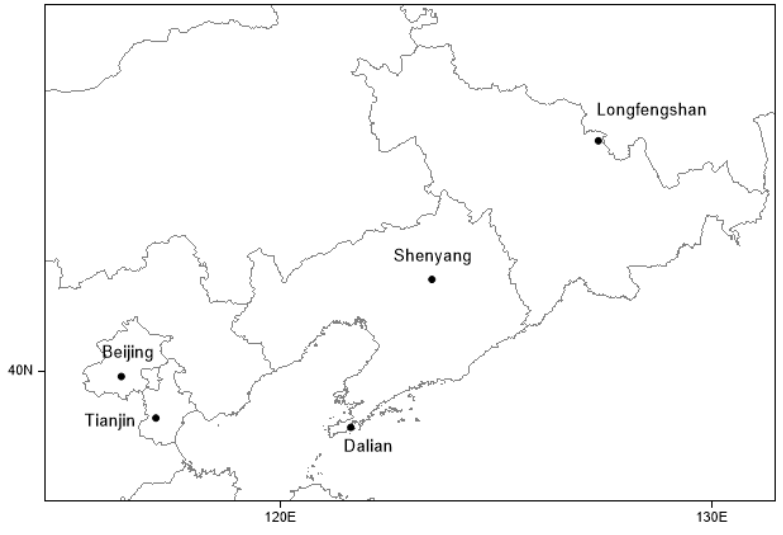
Figure 1. Geographical location of Dalian monitoring station on the southern tip of Liaodong Peninsula, China.